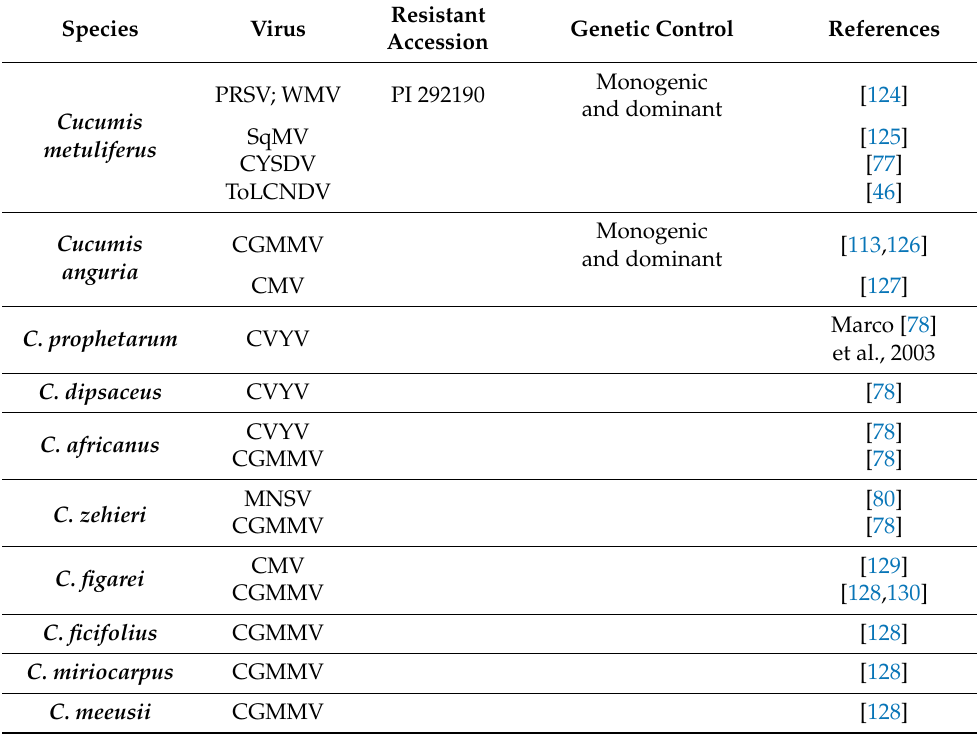
Table 3. Genetic resources for resistance to viruses in other Cucumis spp